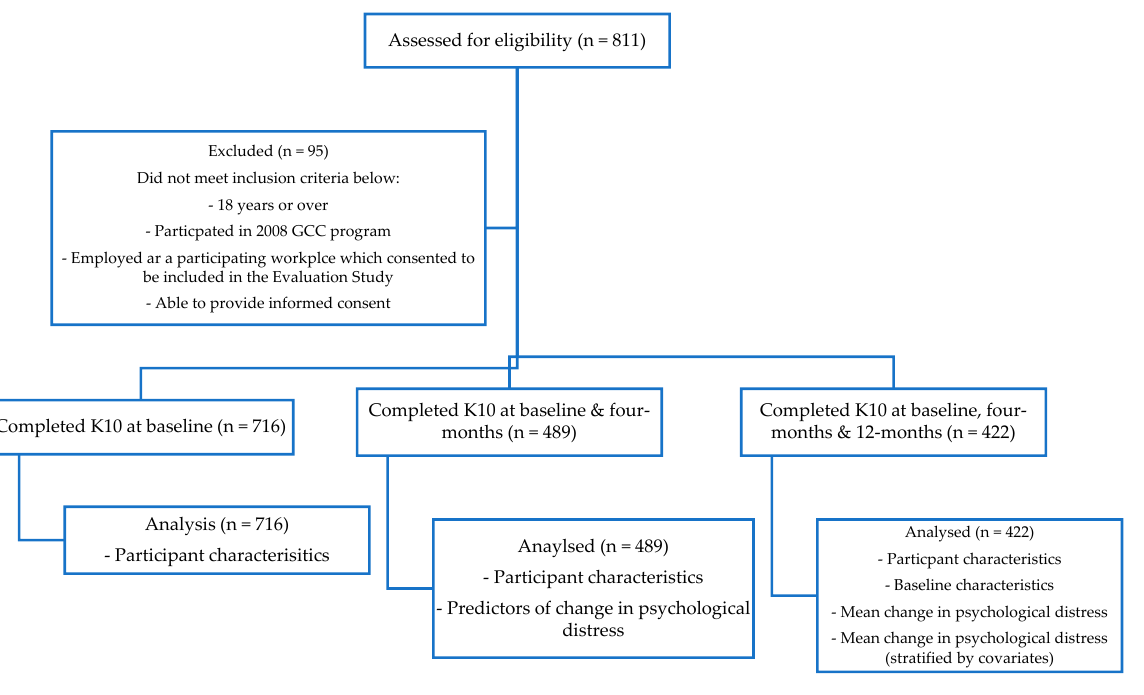
Figure 1. Participant recruitment.